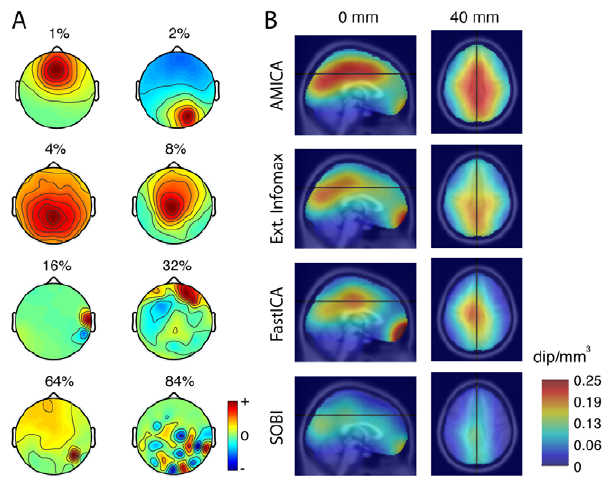
Table 1. Mean mutual information reduction and ‘dipolarity’ measures for each algorithm across 13 data sets.